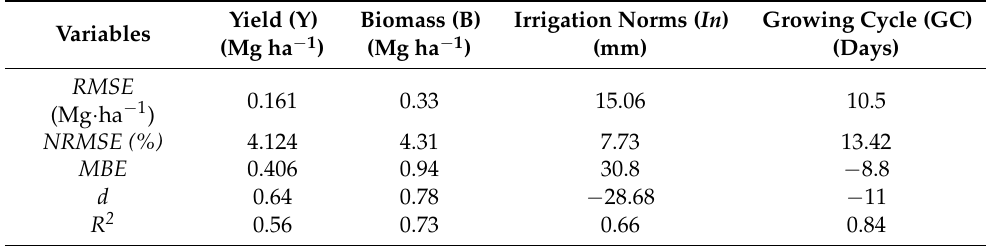
Table 9. Statistical indices of simulated irrigation norms, yield, total biomass, and growing cycle.